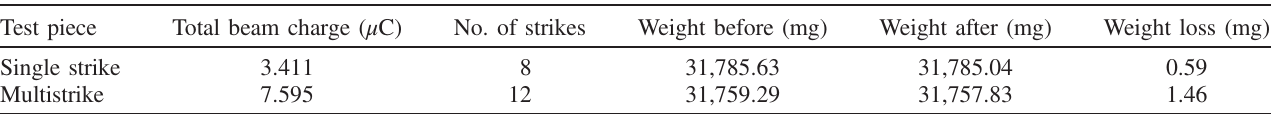
TABLE VIII. Weights and weight loss for the January 2020 collimator test pieces. Test